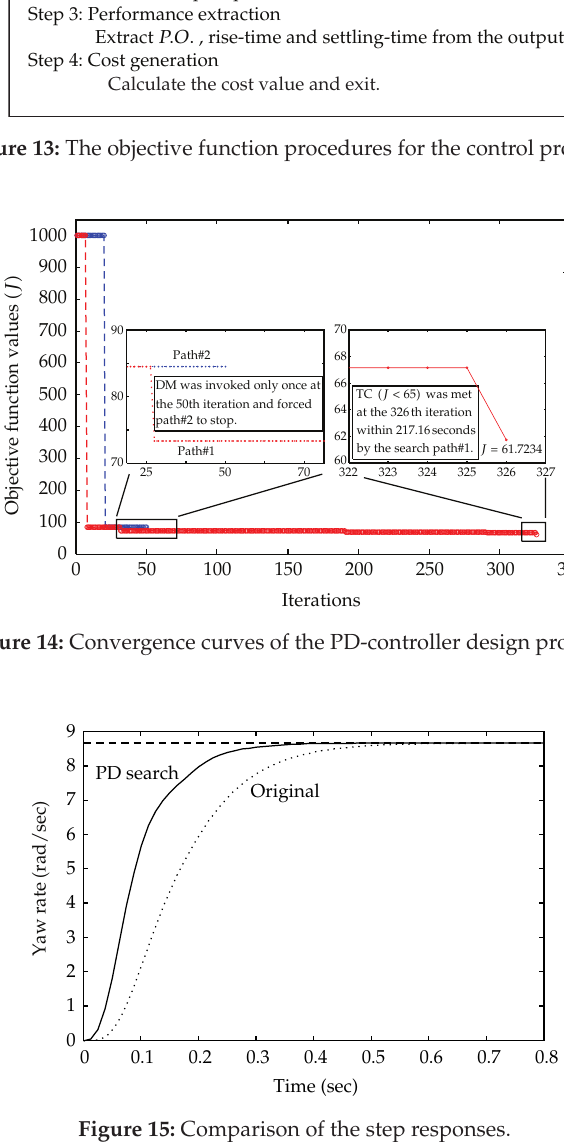
Figure 15: Comparison of the step